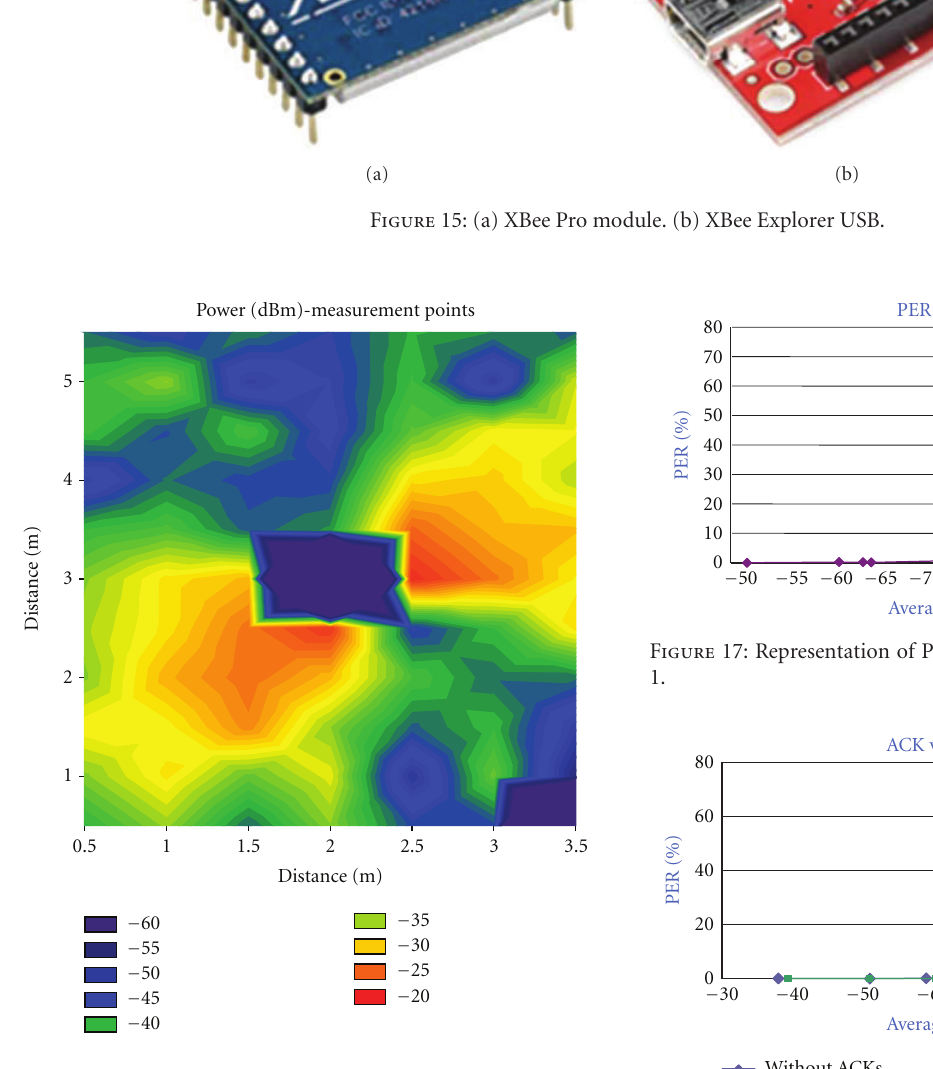
Figure 16: Measured RF power values for indoor scenario 1.